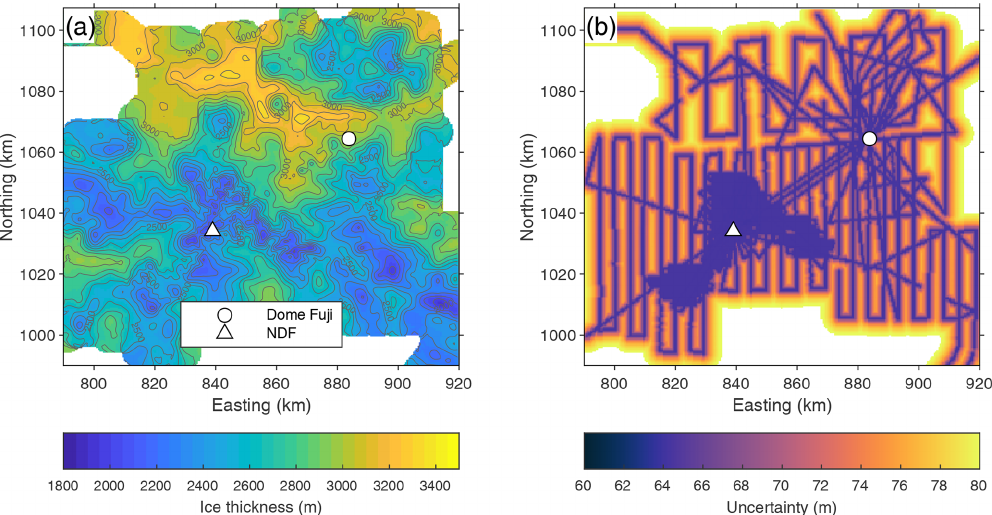
Figure 3. (a) Gridded ice thickness (0.5km horizontal resolution) and contours with intervals of 100m. (b) Uncertainty in the gridded ice